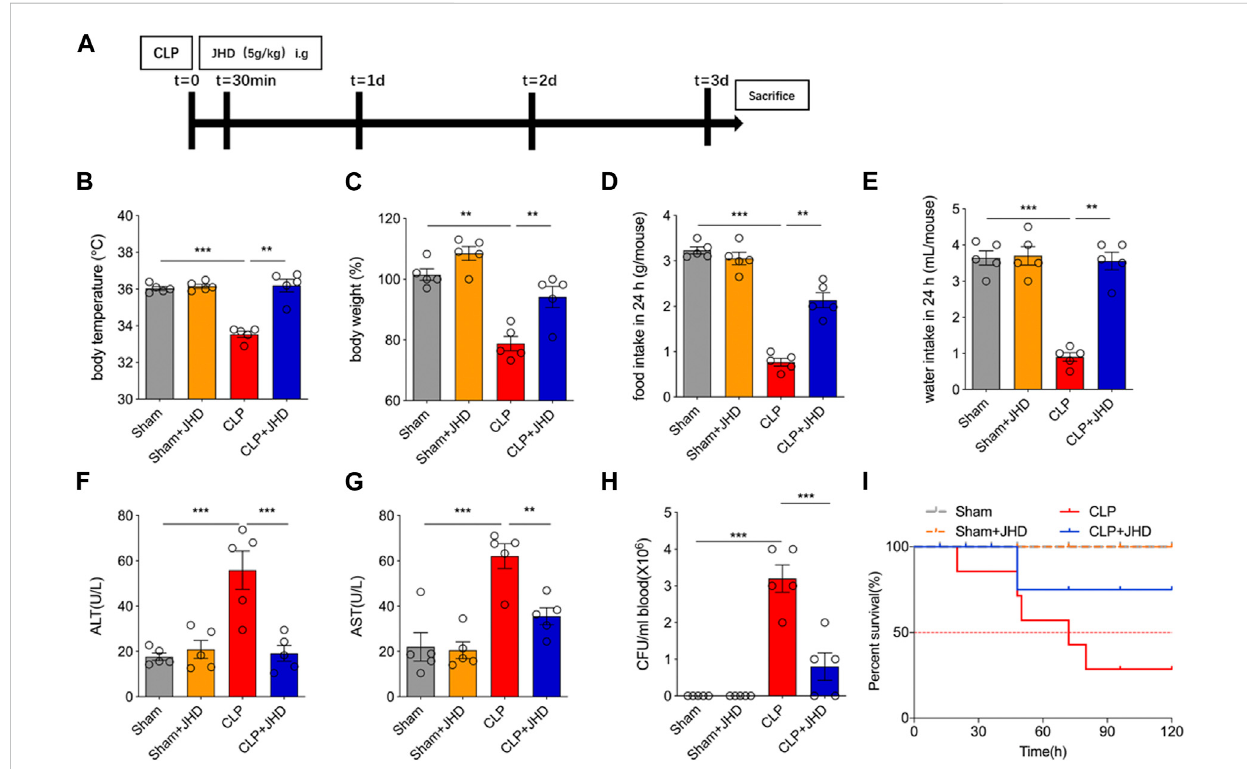
FIGURE 1 JHD attenuated symptoms of CLP-induced sepsis in mice. (A) Flow chart of model establishment and JHD administration; Sepsis-characterized symptoms including (B) body temperature, (C) body weight, (D) food intake, and (E) water intake; Serum level of (F) ALT and (G) AST; (H) Bacterial load in circulation; (I) Survival rates. (mean ± SD, n = 5; * p < 0.05, ** p < 0.01, *** p <